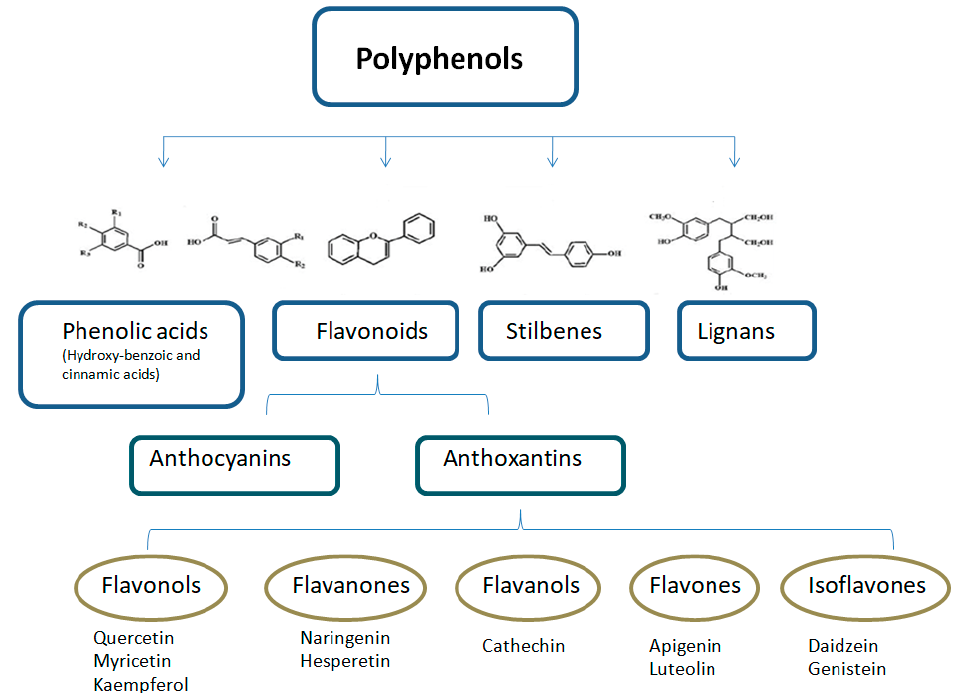
Figure 1. Classification and structure of the main polyphenol classes. Adapted from Pandey KB et al. Oxid. Med. Cell. Longev. 2009, 2, 270–8.